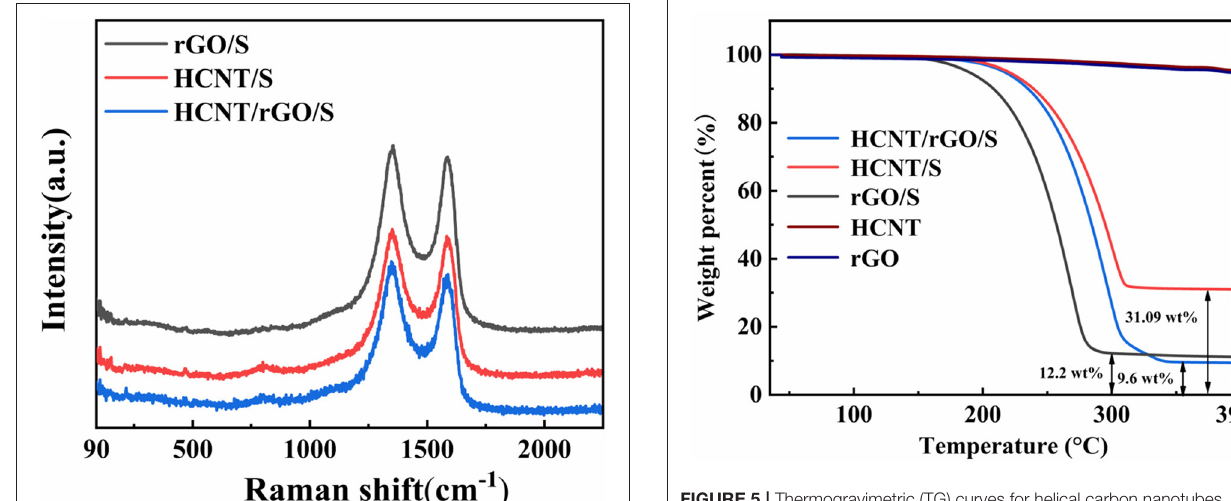
FIGURE 5 | Thermogravimetric (TG) curves for helical carbon nanotubes (HCNT), reduced graphene oxide (rGO), rGO/sulfur (S), HCNT/S, and